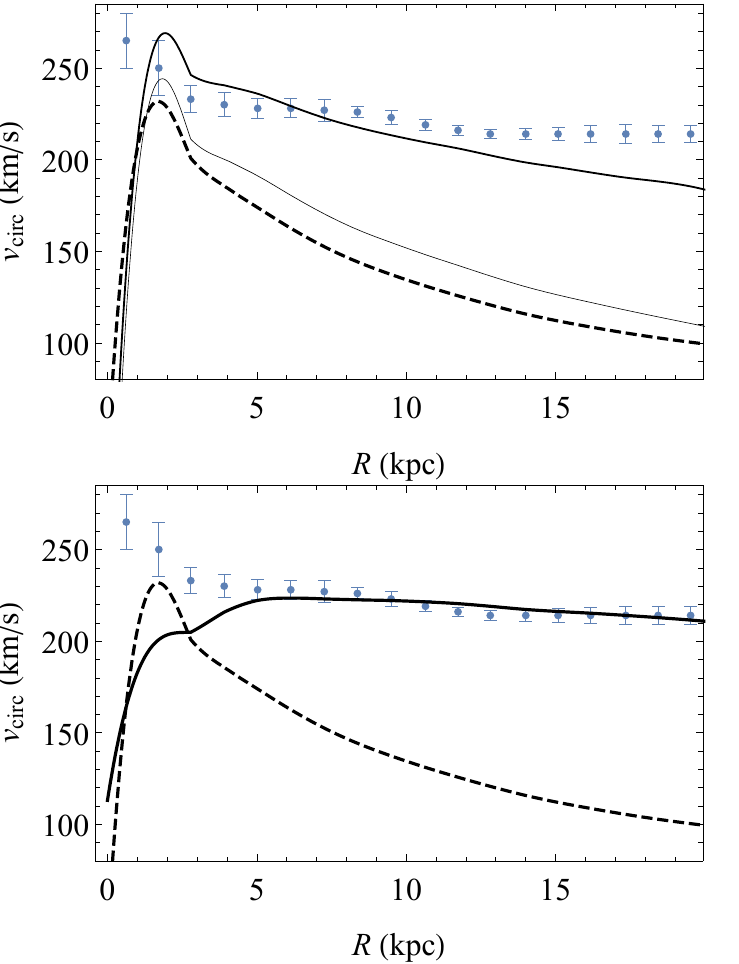
Figure 4 . Comparison of the data points of NGC7814 with the n = 3 rotation curve of the theory T v with weighted derivatives in the limit of weak fractional corrections with a data-based matter density profile for α = 1 (Einstein’s theory, dashed curve), α = 1 . 1 , 1 . 3 and R = 4 kpc (top panel, ∗ increasing thickness) or α = 4 / 3 and R = 5 . 3 kpc (bottom ∗